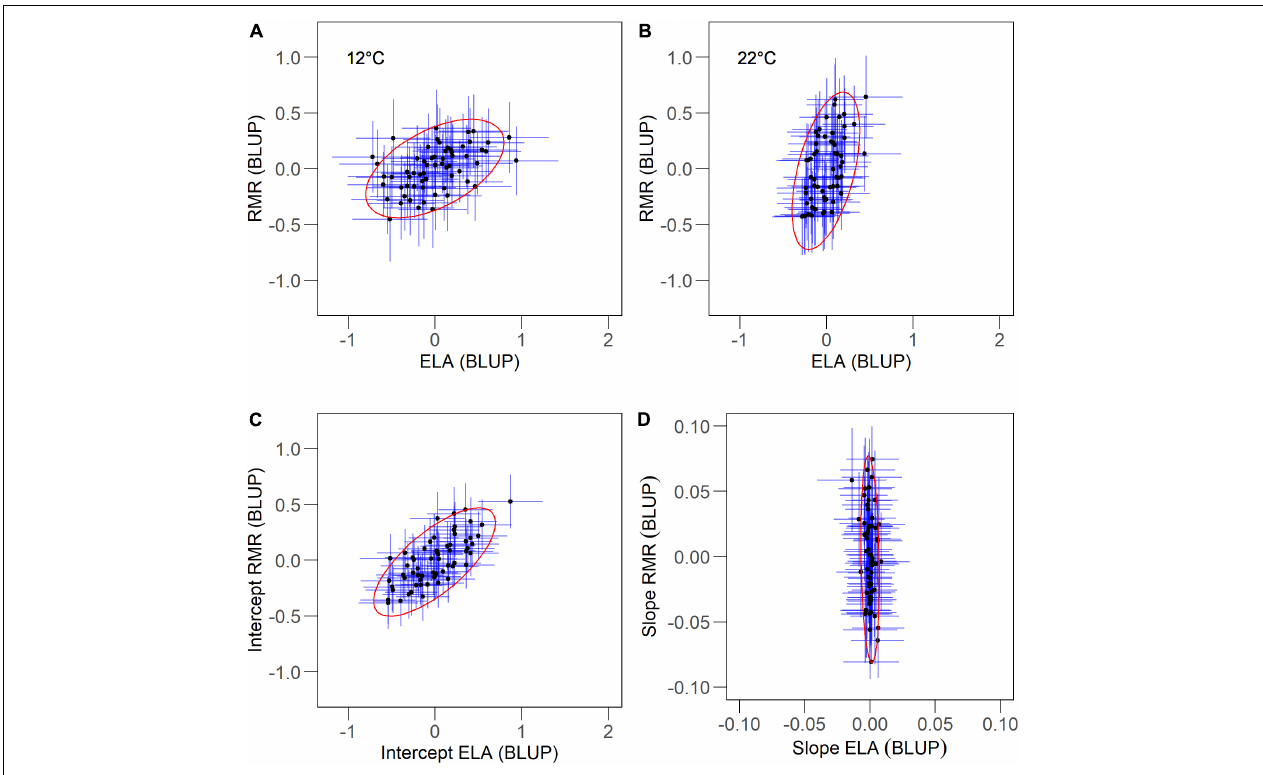
FIGURE 3 | Individual-level associations between resting metabolic rate (RMR) and exploratory locomotor activity (ELA) at two body temperatures (A,B) and as parameters of their thermal reaction norms, intercepts and slopes (C,D) , in juvenile Alpine newts ( Ichthyosaura alpestris ). Values are estimates (SE) of best linear unbiased predictors (BLUP) for each individual from the respective model ( Tables 1 , 3 ). Values are fitted with 95% confidence